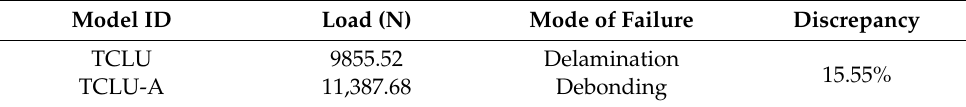
Table 5. Comparison of uplift test models with and without anchorage.